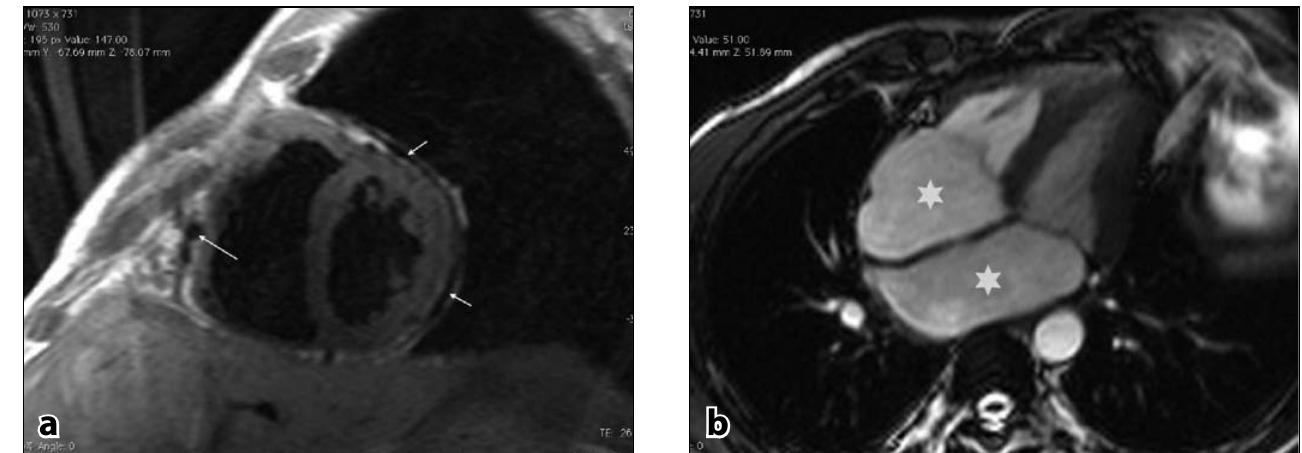
Fig. 3. Constrictive pericarditis. (3a.) Dark blood T1-weighted image clearly depicting the thickened pericardium (arrows) which is nodular in parts (long arrow). (3b.) Bright blood four-chamber image in the same patient showing bi-atrial enlargement (stars), a feature common to constrictive pericarditis and restrictive cardiomyopathy.